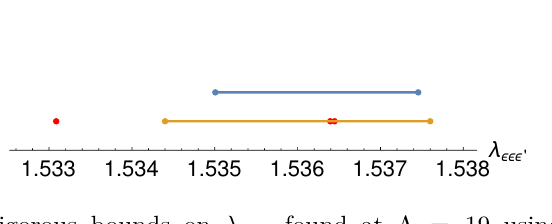
us- (cid:15)(cid:15)(cid:15) 0